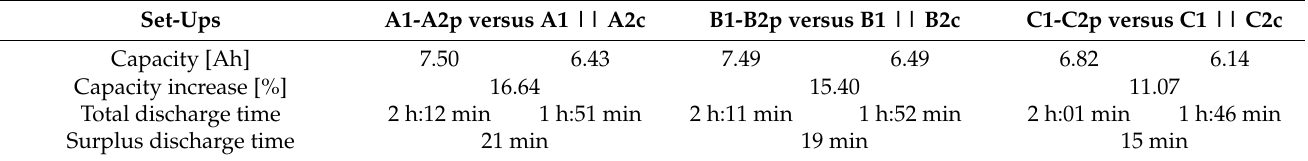
Table 4. Discharge data for two switched batteries versus parallel connected.